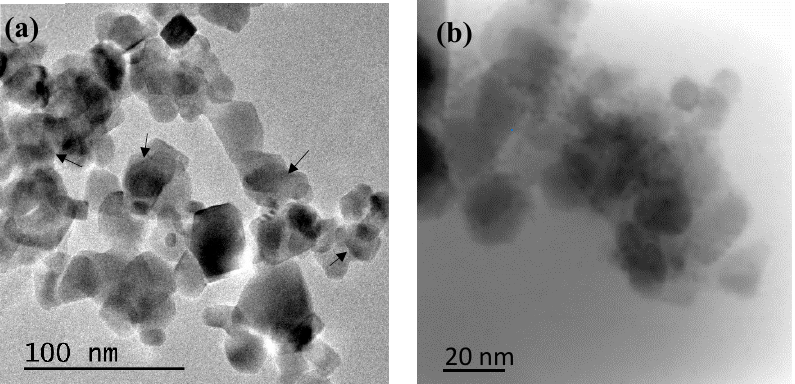
Figure 3. TEM of Pd-modified P25: Pd-P ( a ) and Pd-I ( b ). The latter was obtained using high-angle annular dark-field imaging (HAADF).